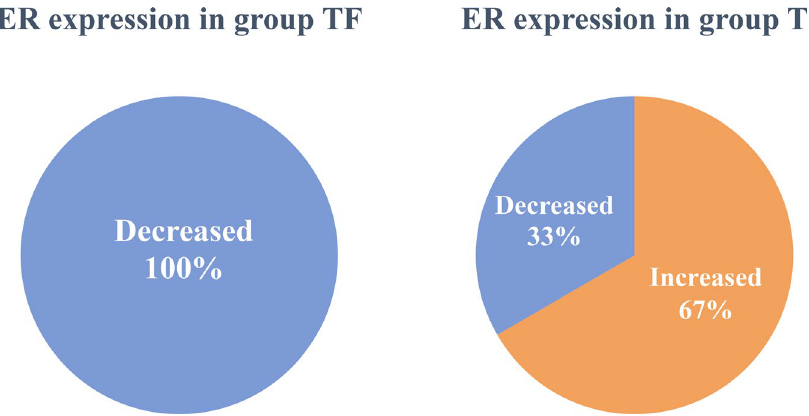
Figure 2. The ER expression changes in patients treated with docetaxel or docetaxel plus